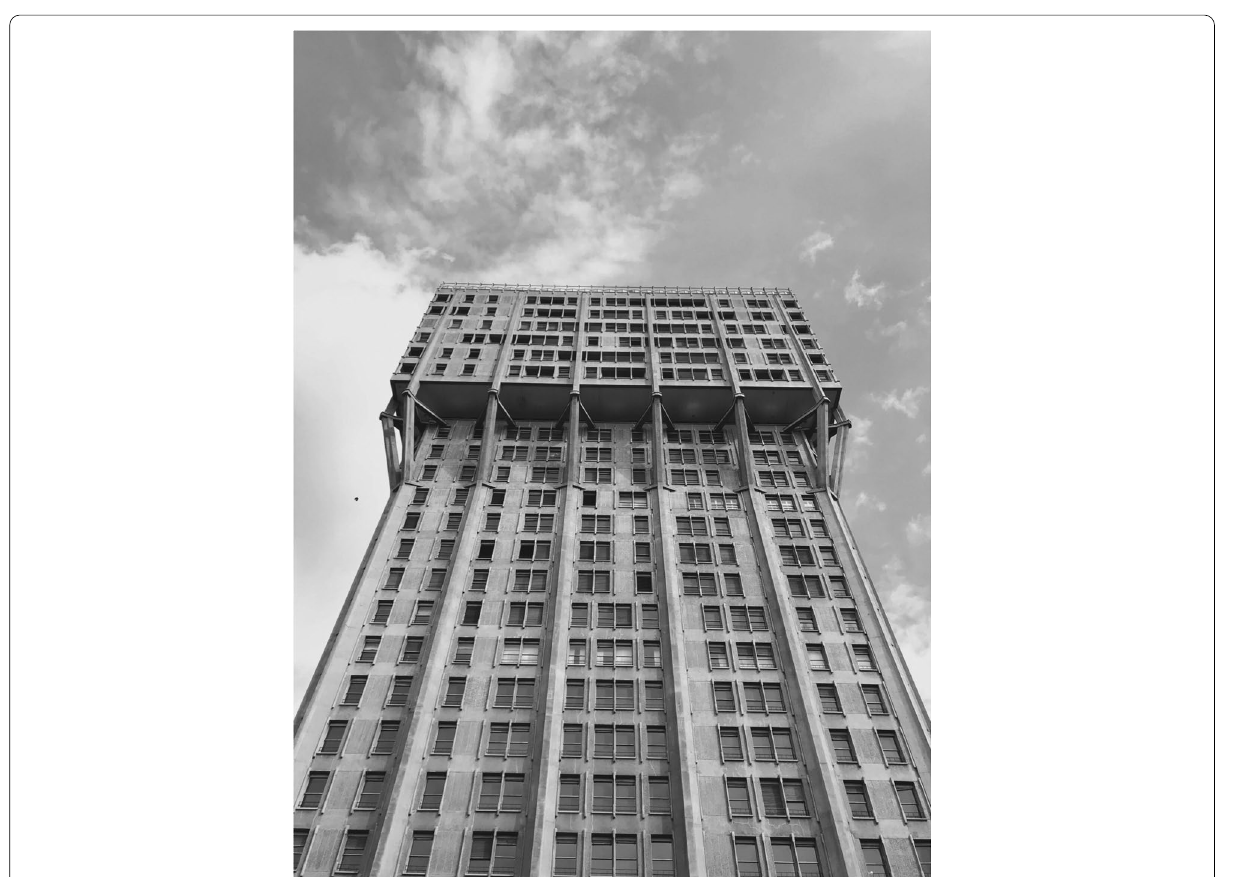
Fig. 11 Torre Velasca (1950–8) by Ludovico Belgiojoso, Enrico Peressutti and Ernesto Nathan Rogers (BBPR). Photograph taken by Marianna Charitonidou, 13 June